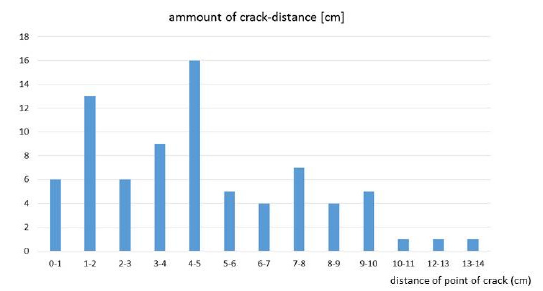
Figure 5. Distance of point of crack from mid-span